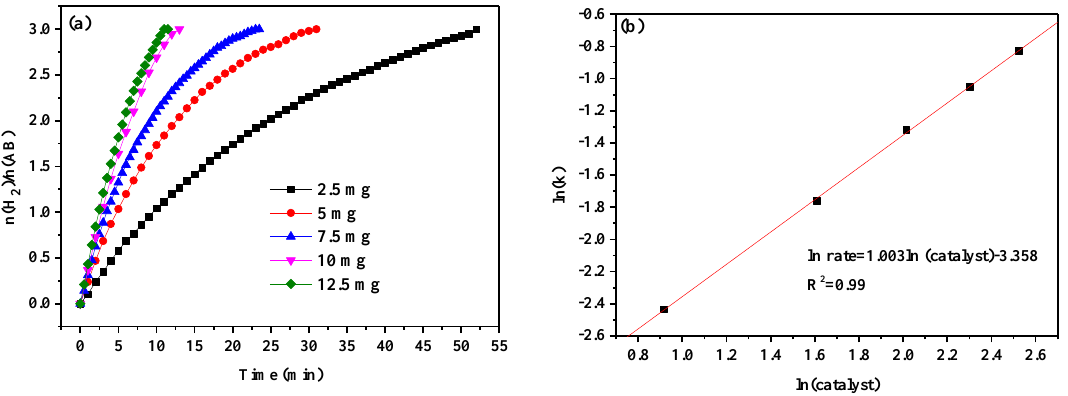
Figure 7. ( a ) AB hydrolysis with different dosage of MoO 3 -doped MnCo 2 O 4 (0.10), and ( b ) the corresponding plot of ln(k) vs. ln(catalyst).